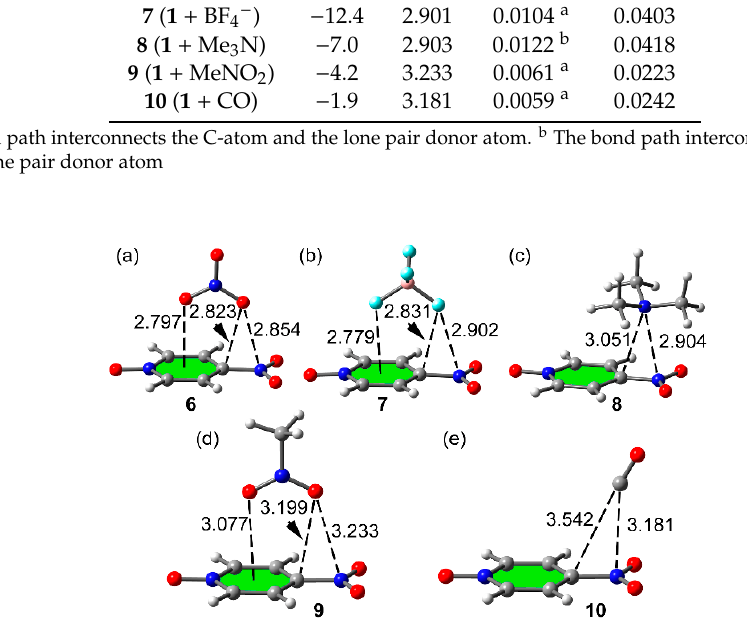
Figure 4. PBE0 / def2-TZVP optimized π –hole complexes 6 ( a ), 7 ( b ), 8 ( c ), 9 ( d ) and 10 ( e ). Distances in Å.